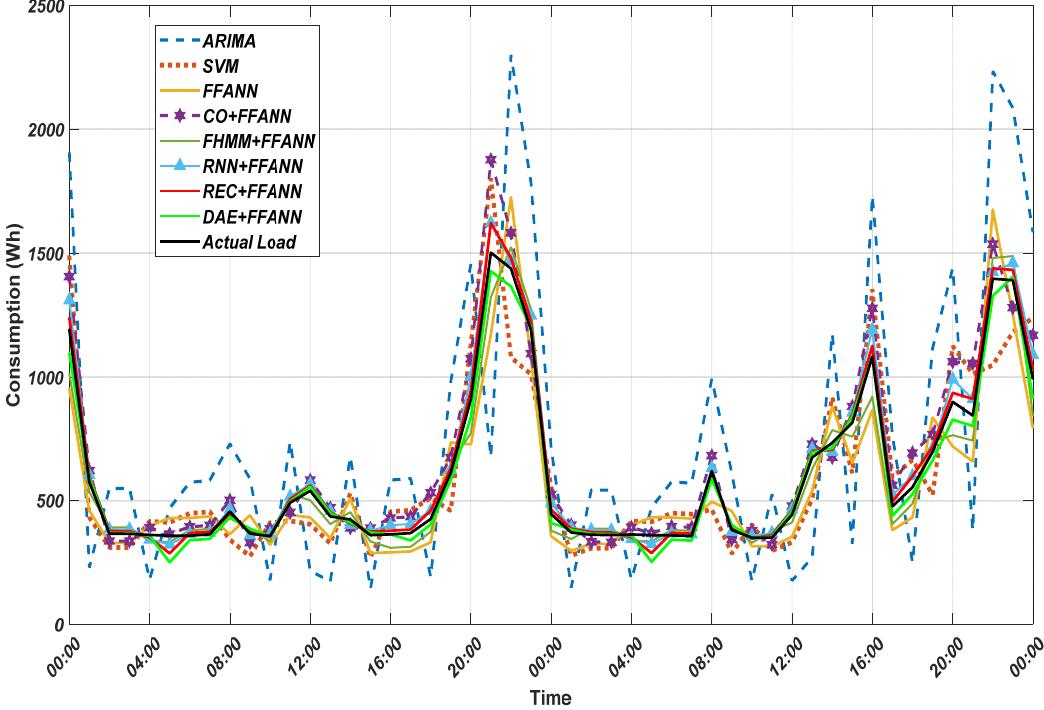
Figure 10. The actual and forecasted load by a different method for the home was unseen during the ED training.